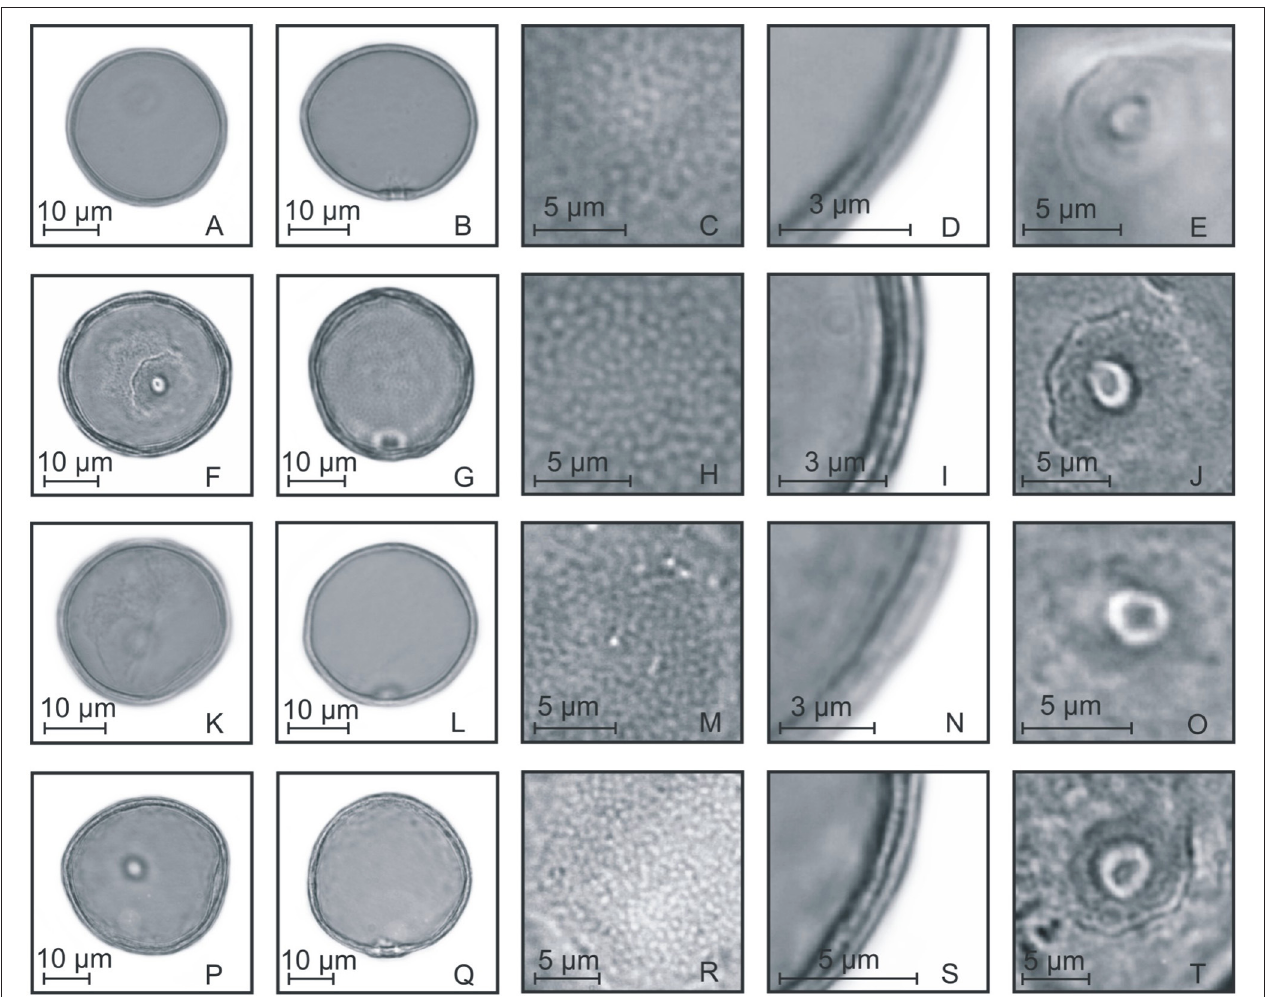
FIGURE 6 | Pollen grains of the subfamilies Chloridoideae, Aristidoideae, and Pooideae. (A–E) Pappophorum philippianum : PV (A) , EV (B) , detail of ornamentation (C) , detail of the thickness of the exine (D) , and detail of the aperture (E) ; (F–J) Aristida sp.: PV (F) , EV (G) , detail of ornamentation (H) , detail of the thickness of the exine (I) , and detail of the aperture (J) ; (K–O) Chascolytrum subaristatum : PV (K) , EV (L) , detail of ornamentation (M) , detail of the thickness of the exine (N) , and detail of the aperture (O) ; (P–T) Bromus catharticus : PV (P) , EV (Q) , detail of ornamentation (R) , detail of the thickness of the exine (S) , and detail of the aperture (T)